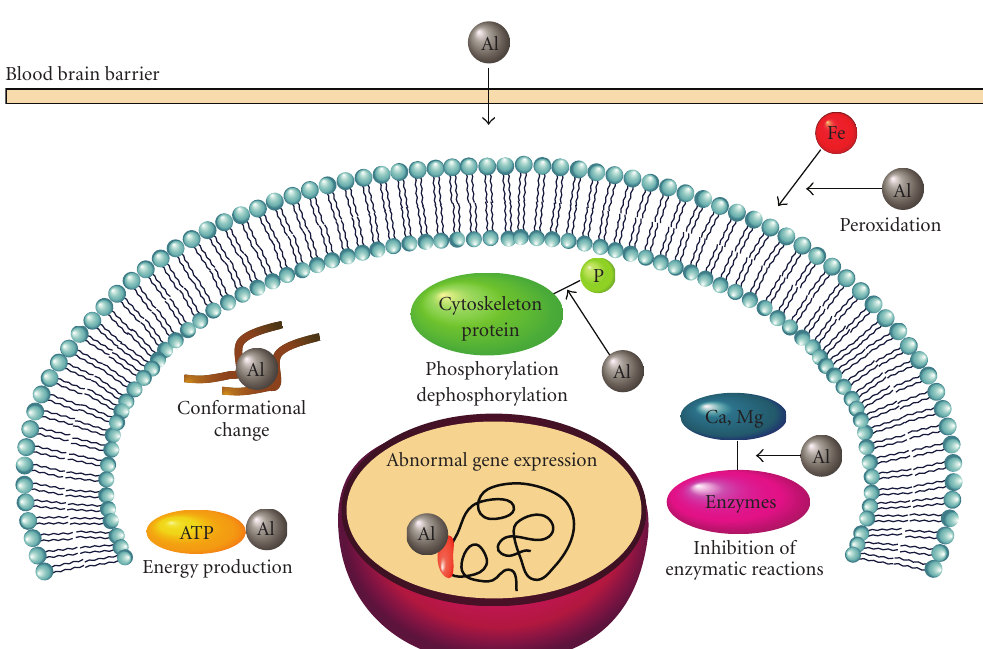
Figure 1: E ff ects of aluminum on the central nervous system. Major biological e ff ects of Al on the central nervous system are